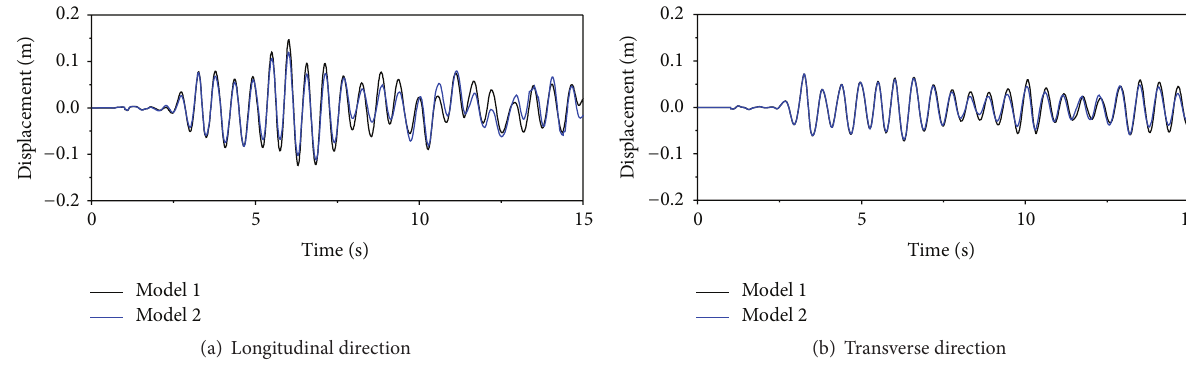
Figure 6: Comparison of the displacement time histories on the top of the transmission towers of the two models of the suspension type.